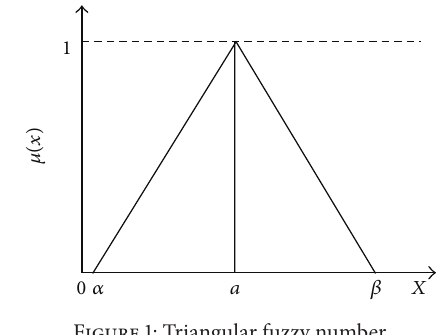
Figure 1: Triangular fuzzy